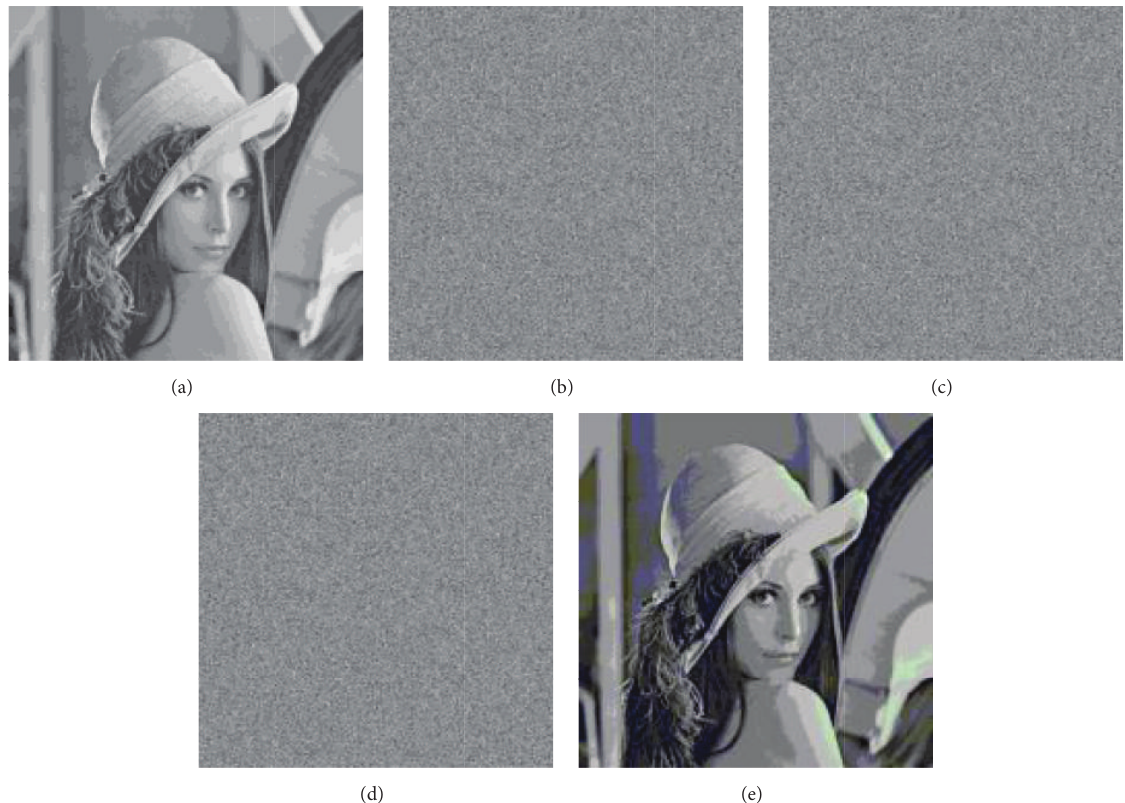
Figure 2: (a) Original image; (b) encrypted image; (c) encrypted image containing watermark; (d) reconstructed image; (e) decrypted